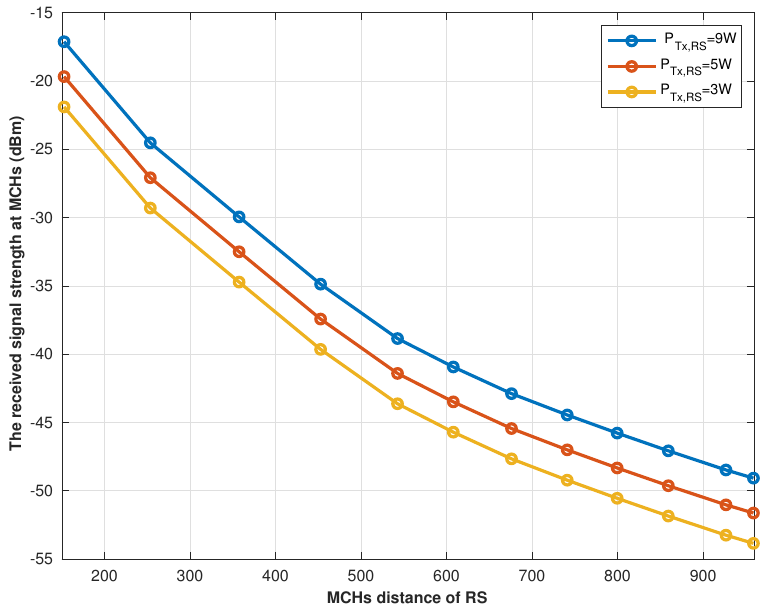
Figure 8. The received signal strength at MCH i .